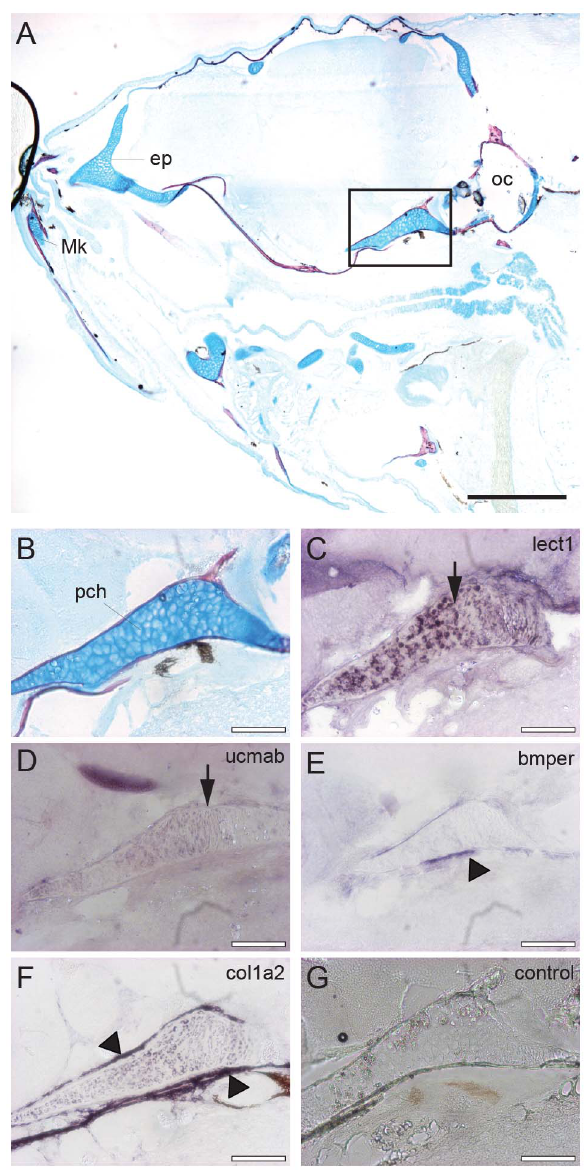
tion in the head region. Sagittal sections of the head region of 28 dpf zebrafish juveniles stained by acid-free bone (red) and cartilage (blue) staining (A-B), or used for in situ hybridization with an antisense RNA probe corresponding to lect1 (C), ucmab (D), bmper (E), col1a2 (F). As a control, hybridization with the lect1 sense RNA probe is shown (G). (B-G) Magnification of boxed area in A focusing on the parachordal (pch) cartilage. Images are from consecutive sections at the same position. (C-D) Expression of lect1 and ucmab is located in chondro- cytes of the parachordal (pch) cartilage (arrows). (E-F) Transcripts of bmper and col1a2 were detected in ossification sites surrounding the parachondral chondrocytes (arrow heads). Scale bars indicate 0.5 mm (black), or 100 m m (white). Abbreviations: ep, ethmoid plate; Mk, Meckel’s cartilage; oc, otic capsule; pch, parachordal. doi:10.1371/journal.pone.0090568.g006 mental stages. The use of transgenic lines that allow visualization of osteoclasts in vivo will be a tremendous tool to correlate protein distribution with osteoclast activity in the future [75].